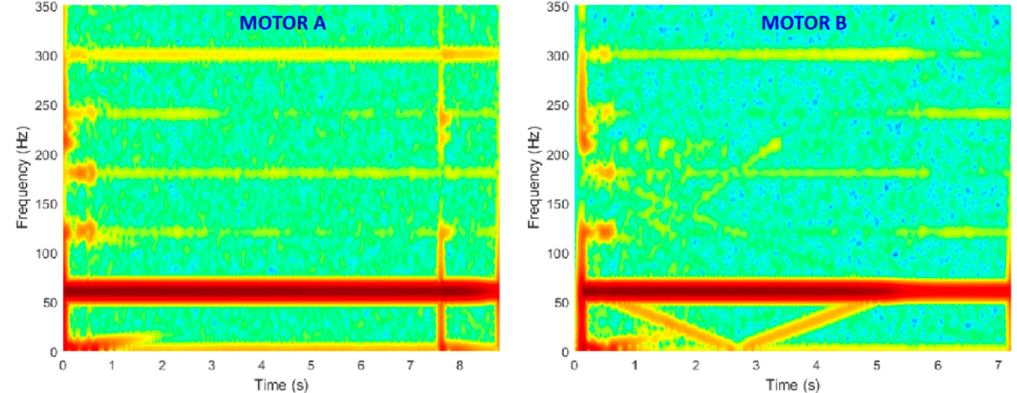
Figure 8. Time-frequency maps of the starting current for two H.V. cage motors of the water intake